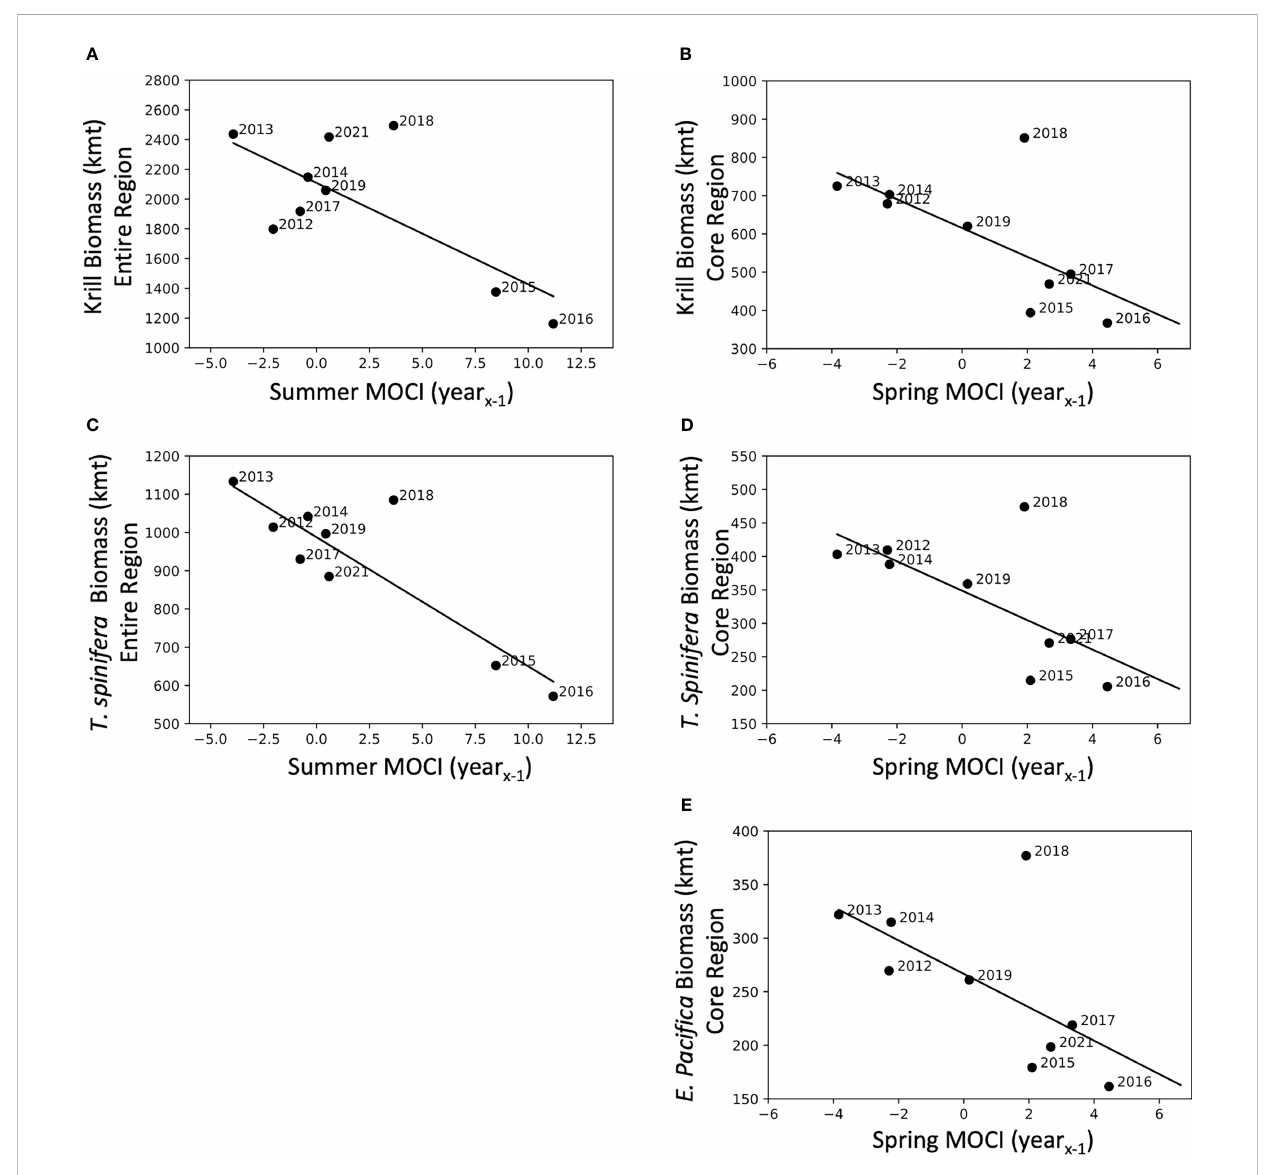
FIGURE 6 Krill biomass predicted by seasonal MOCI in the previous year (year x-1 ). Krill biomass (A) and Thysanoessa spinifera biomass (C) for the entire region compared to Summer MOCI (year x-1 ), and krill biomass (B) , T. spinifera biomass (D) , and Euphausia paci fi ca biomass (E) from the core region compared to Spring MOCI (year x-1 ). Coef fi cients of determination and signi fi cance are reported in Table